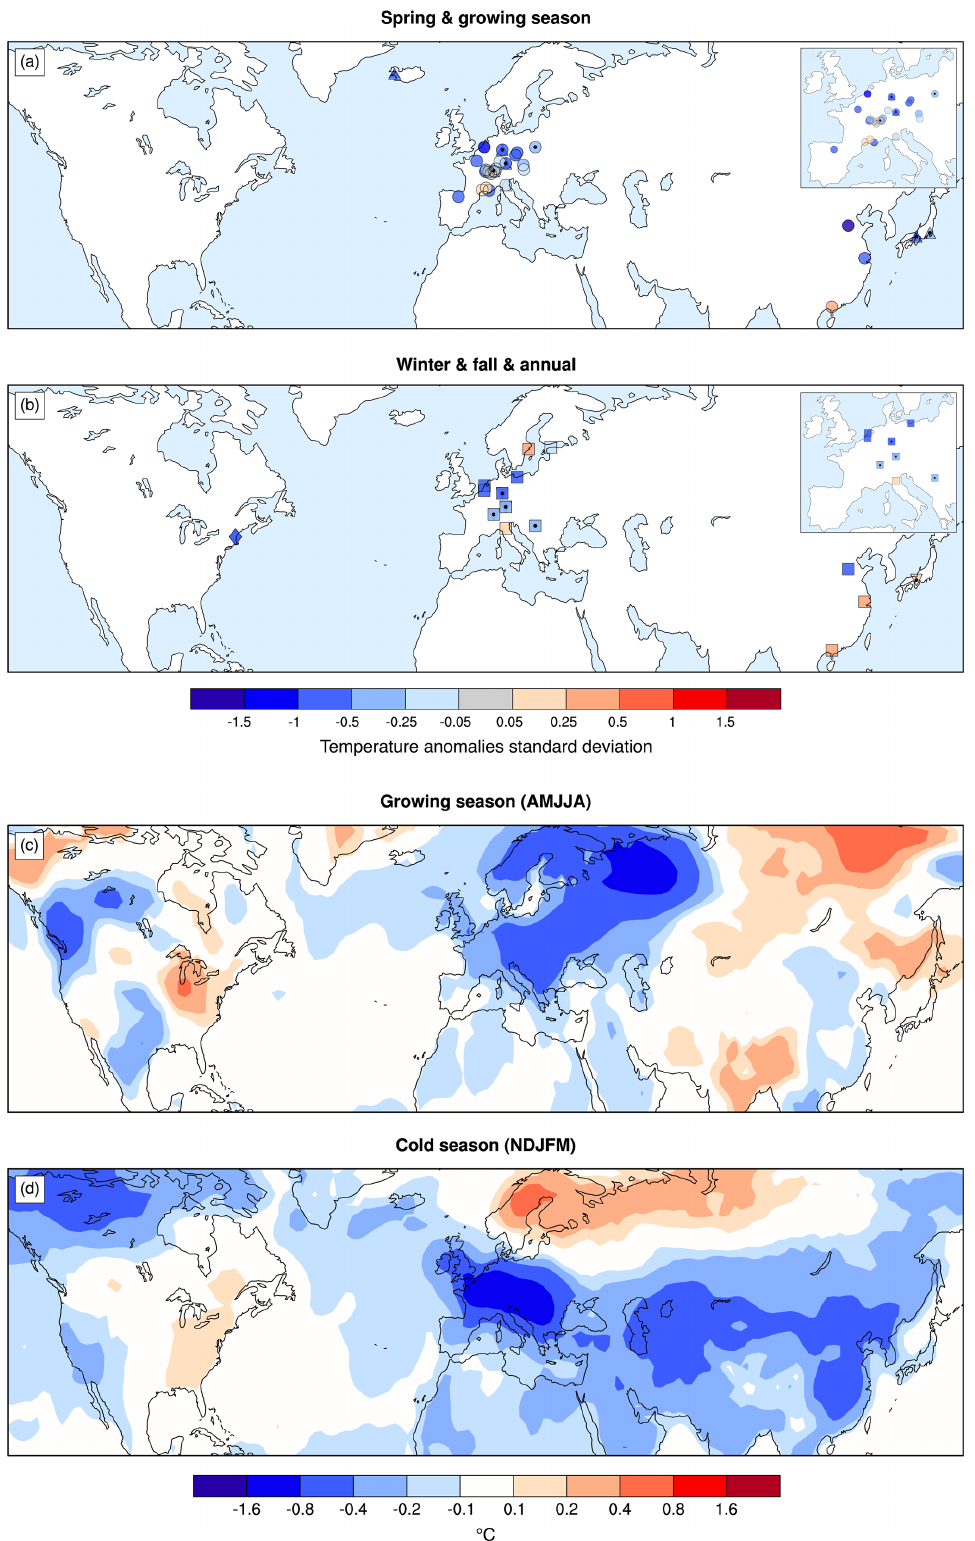
Figure 3. Temperature composites of documentary series for the 1693 and 1695CE volcanic eruptions. Proxy series are categorized into seasonal groups: (a) shows spring and growing season proxies, whereas (b) comprises fall, winter, and annual proxies. Panels (c) and (d) show composites of 2m surface air temperature during the growing season (April–August) and cold season (November–March), respectively, based on the EKF400v2.0 reanalysis. Documentary proxies assimilated in the EKF400v2 are indicated by a black dot in (a) and (b) . Clim. Past, 18, 1407–1428, 2022